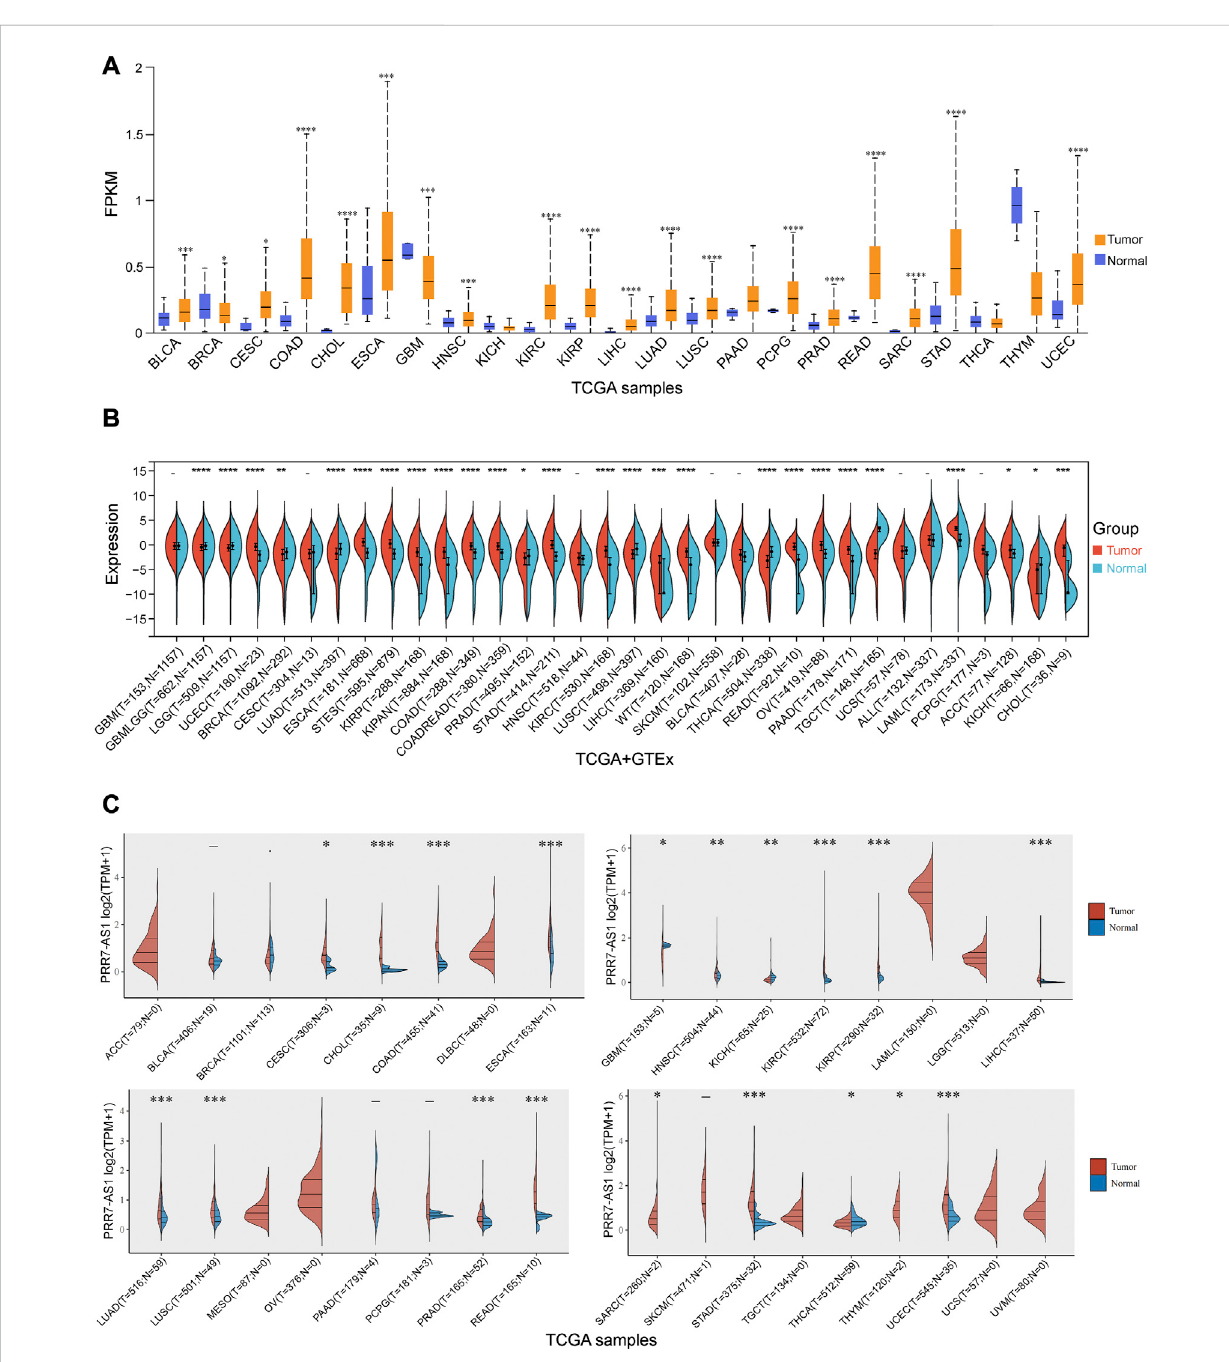
Expression levels of PRR7-AS1 in pan-cancer. (A) The expression levels of PRR7-AS1 in normal and tumor tissues were analyzed using the UALCAN database. (B) The expression differences of PRR7-AS1 between normal and corresponding tumor tissues from the Sangerbox database. (C) Differential expression levels of PRR7-AS1 in tumor and normal tissues were analyzed using the ACLBI database. * p < 0.05, ** p < 0.01, *** p < 0.001, **** p <